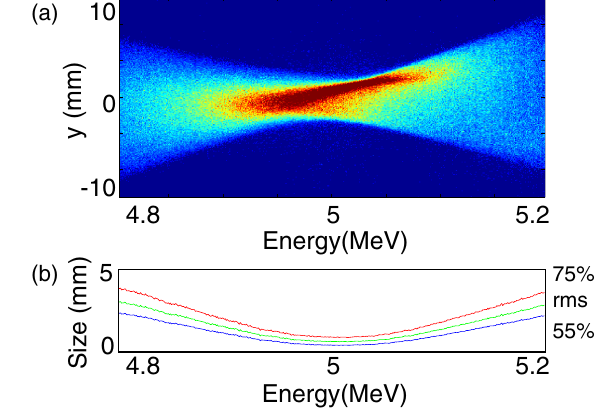
FIG. 4. Single-shot emittance measurements. (a) Example single-shot detected image. (b) Measured beam size variation with energy.